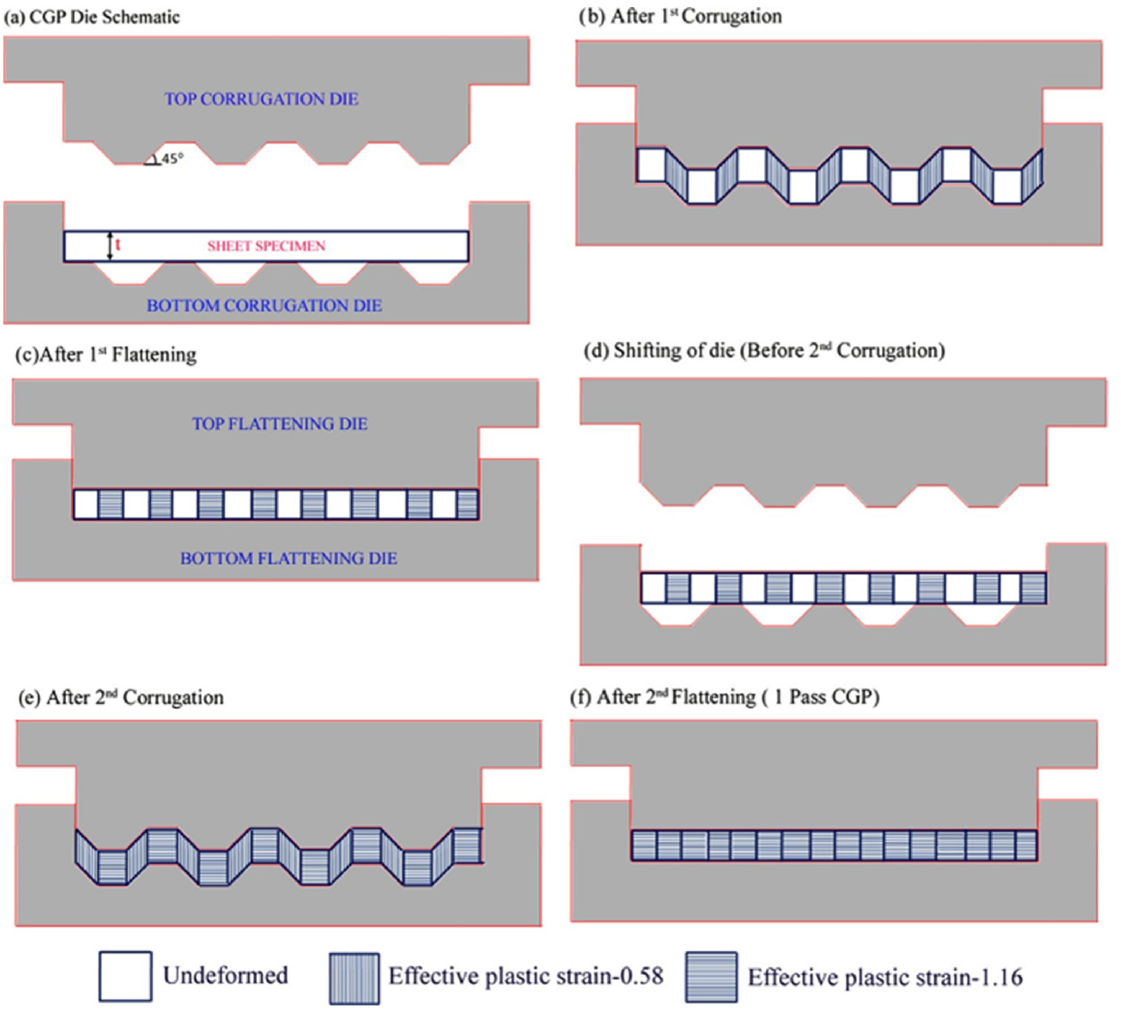
Figure 2. Schematic representation of the plastic strain evolution during the constrained groove pressing process, ( a ) CGP Die Schematic, ( b ) After 1st Corrugation, ( c ) After 1st Flattening, ( d ) Shifting of die (Before 2nd Corrugation), ( e ) After 2nd Corrugation, ( f ) After 2nd Flattening. Adapted with permission from [81], 2022, Elsevier.